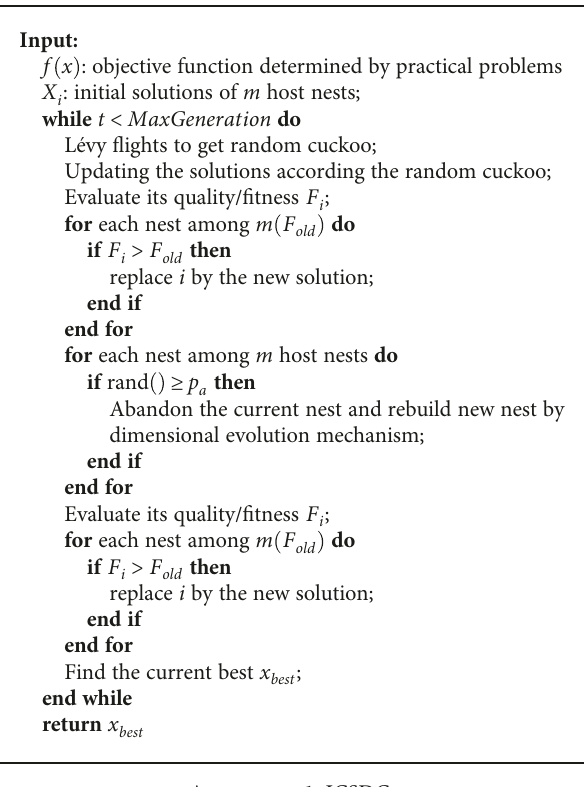
Algorithm 1: ICSDC.